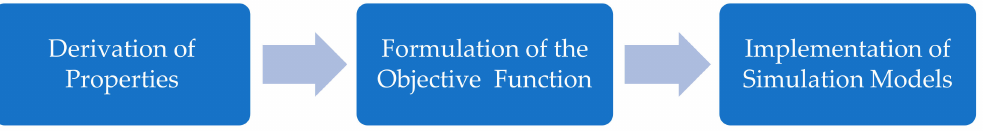
Figure 1. Overview of the overall methodology.